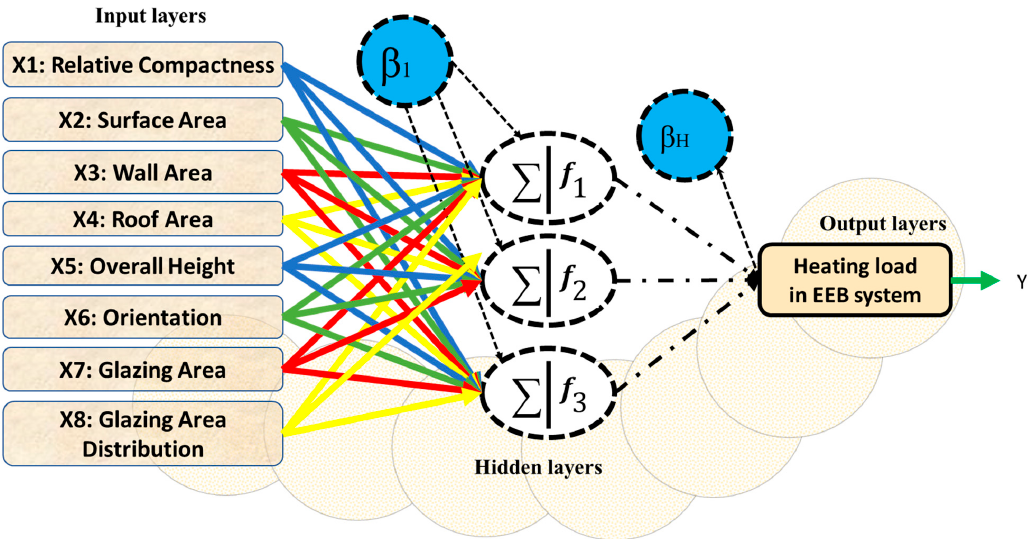
Figure 4. Multi-layer perceptron regressor (MLPr) neural network typical architecture.